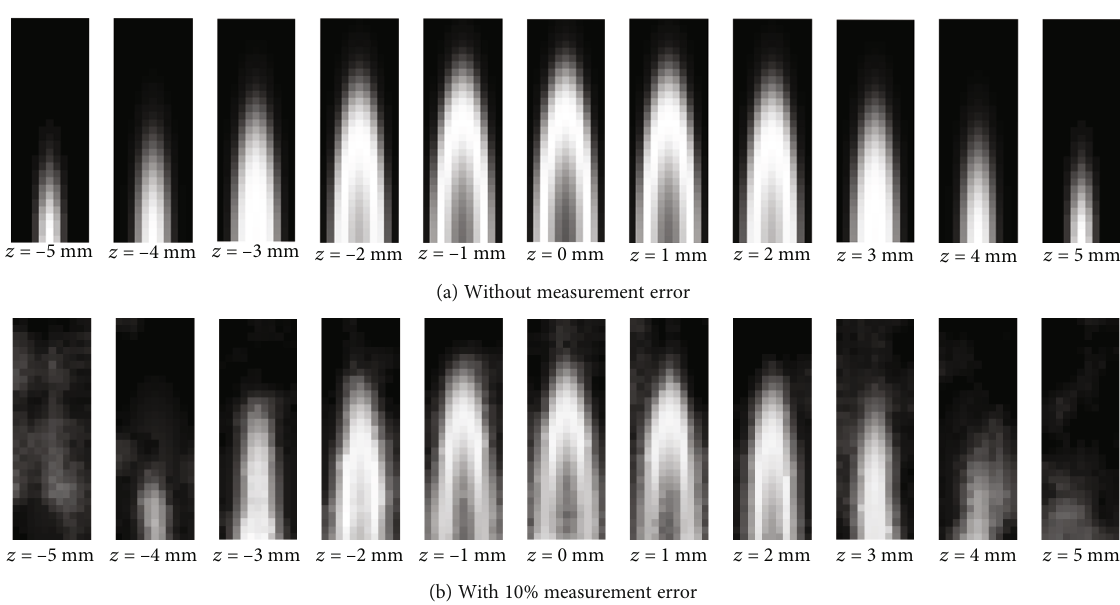
Figure 12: The reconstruction results of the fl ame temperature pro fi